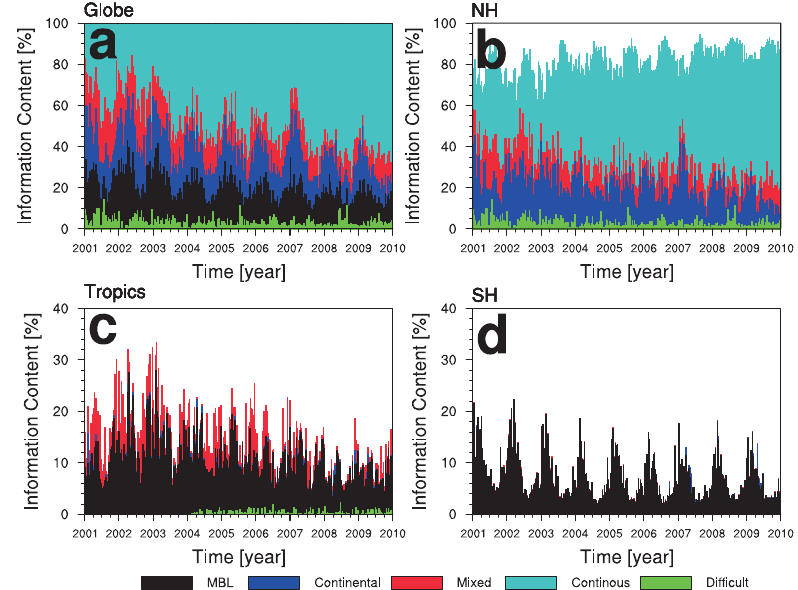
Figure 11. Time series of the average information content for each observation site category (a) around the globe and in the (b) Northern Hemisphere, (c) tropics, and (d) Southern Hemisphere from 2001 to 2009.